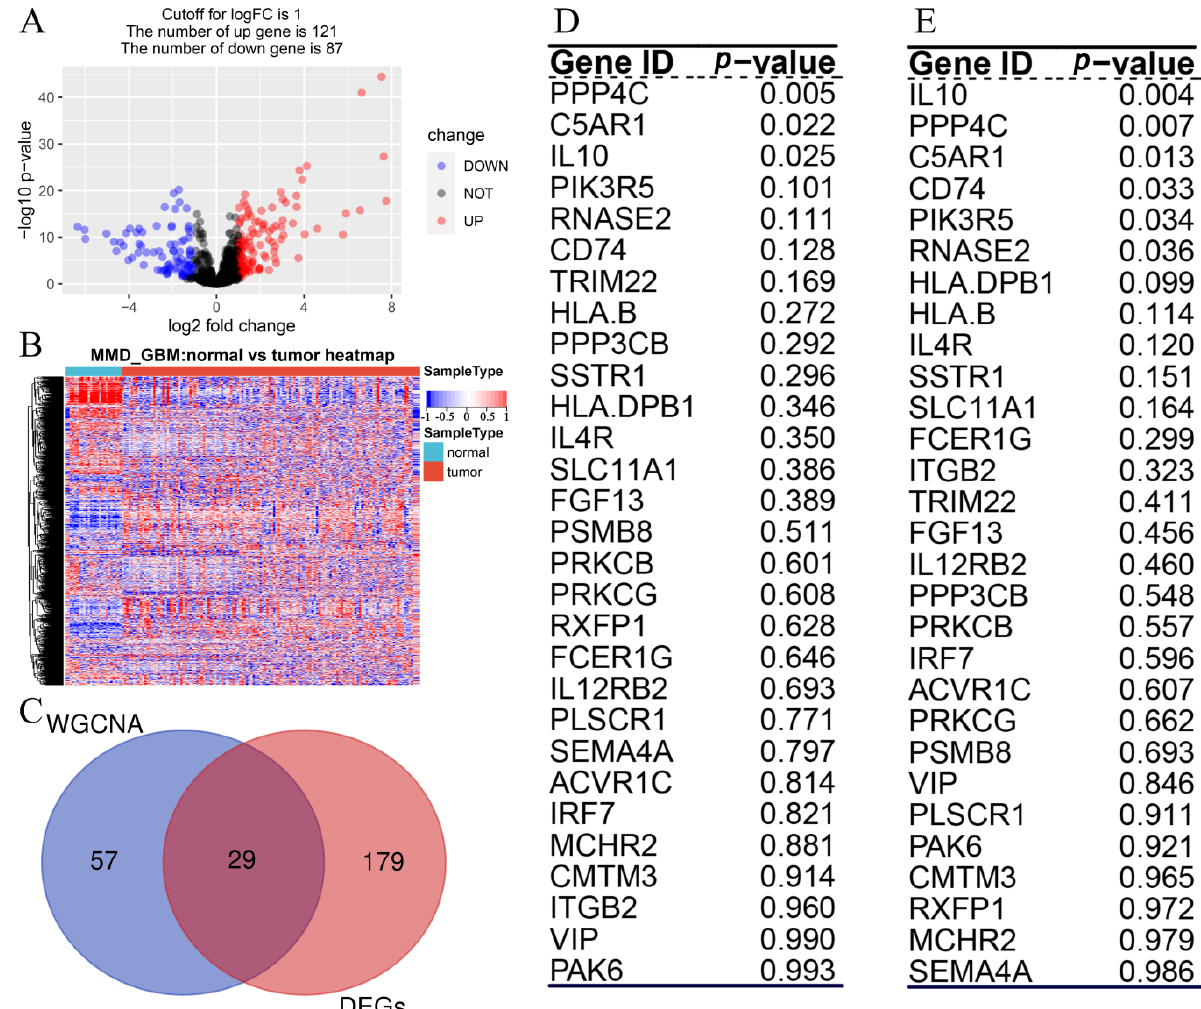
Figure 3. IRG identification. ( A ) Volcano plot displaying differentially expressed IRGs in MMD1- GBM data. ( B ) Heatmap of IRGs differently expressed in tumor samples compared to normal samples (fold change >1, p < 0.05, MMD1). ( C ) Venn diagrams of DEGs and IRGs identified in WGCNA. ( D ) Result of independent survival analysis for 29 IRGs in TCGA-GBM(OS). ( E ) Result of independent survival analysis for 29 IRGs in TCGA-GBM(DSS).